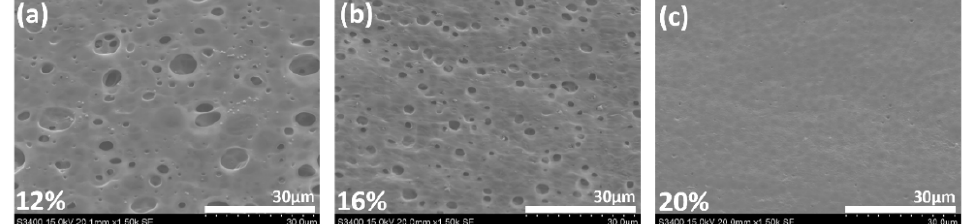
Table 1. Surface and inner pore size analysis at various weight percentages (wt.%) of polysulfone (PSF) membrane.